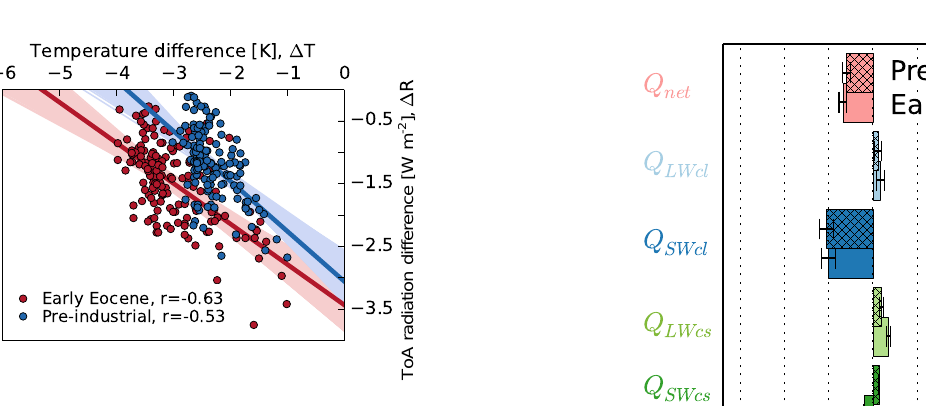
Figure 10. Evolution of differences in the TOA radiative flux be- tween the forest world and the dark desert world with corresponding temperature differences. Global annual mean values are considered. Red and blue points relate to the early Eocene climate and to the pre-industrial climate, respectively. The first 150 years are shown and considered for the regression and the correlation coefficient, r . The shaded areas refer to the 95% confidence interval for the re- gression lines.